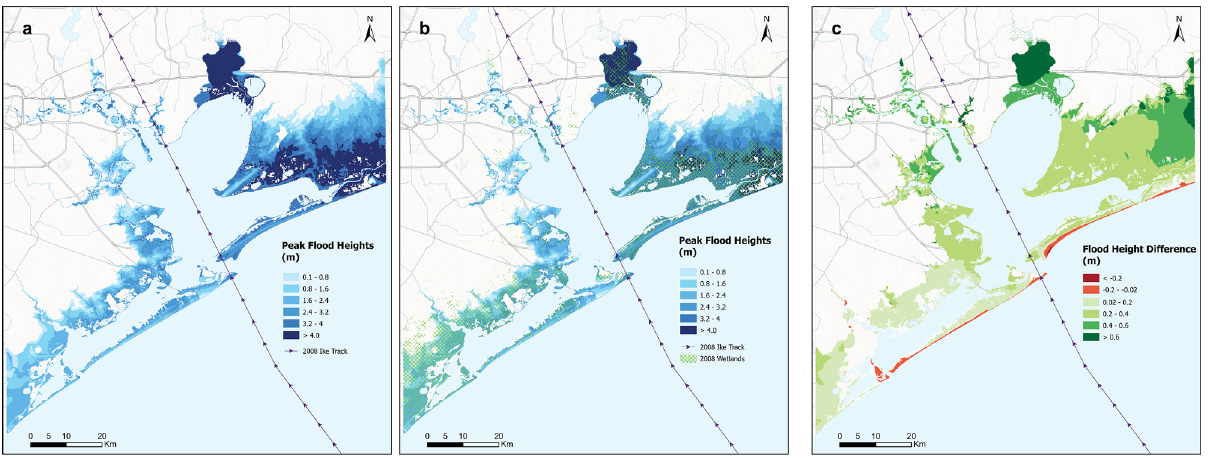
Figure 1. Simulated peak flood heights (m) showing the difference between flood elevations and the topographical (i.e. ground) surface from Hurricane Ike over regions in Galveston Bay for: ( a ) 2008 No wetlands, ( b ) 2008 Baseline, and ( c ) Difference (No Wetlands 2008 – Baseline 2008). Topographical and flood elevations are all relative to